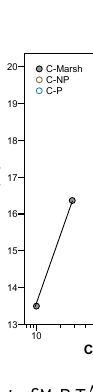
Figure 11. Time plot of MBT (cid:48) –CBT-derived temperatures ( T MC ) in soils of Cixi. Note logarithmic scale for cultivation